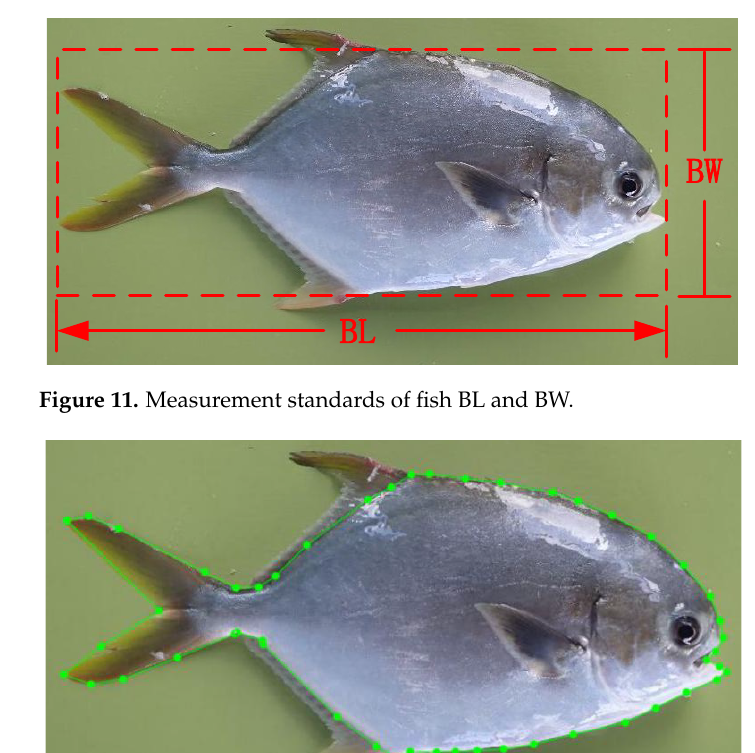
Fig. 7 Measurement standard of fish body area.